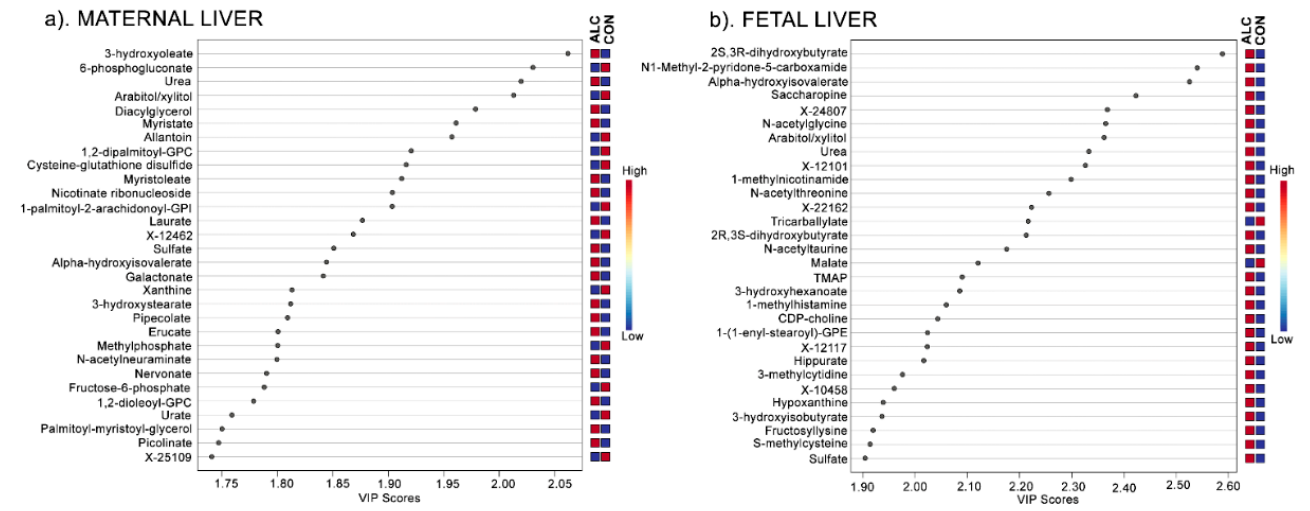
Figure 2. VIP Scores Plot of the top 30 metabolites in maternal liver ( a ) and fetal liver ( b ) that contribute to the separation of ALC vs. CON metabolite profiles in the Component 1 in the PLSDA. The blue and red boxes on the right indicate whether the mean metabolite abundance is increased (red) or decreased (blue) in ALC vs. CON.